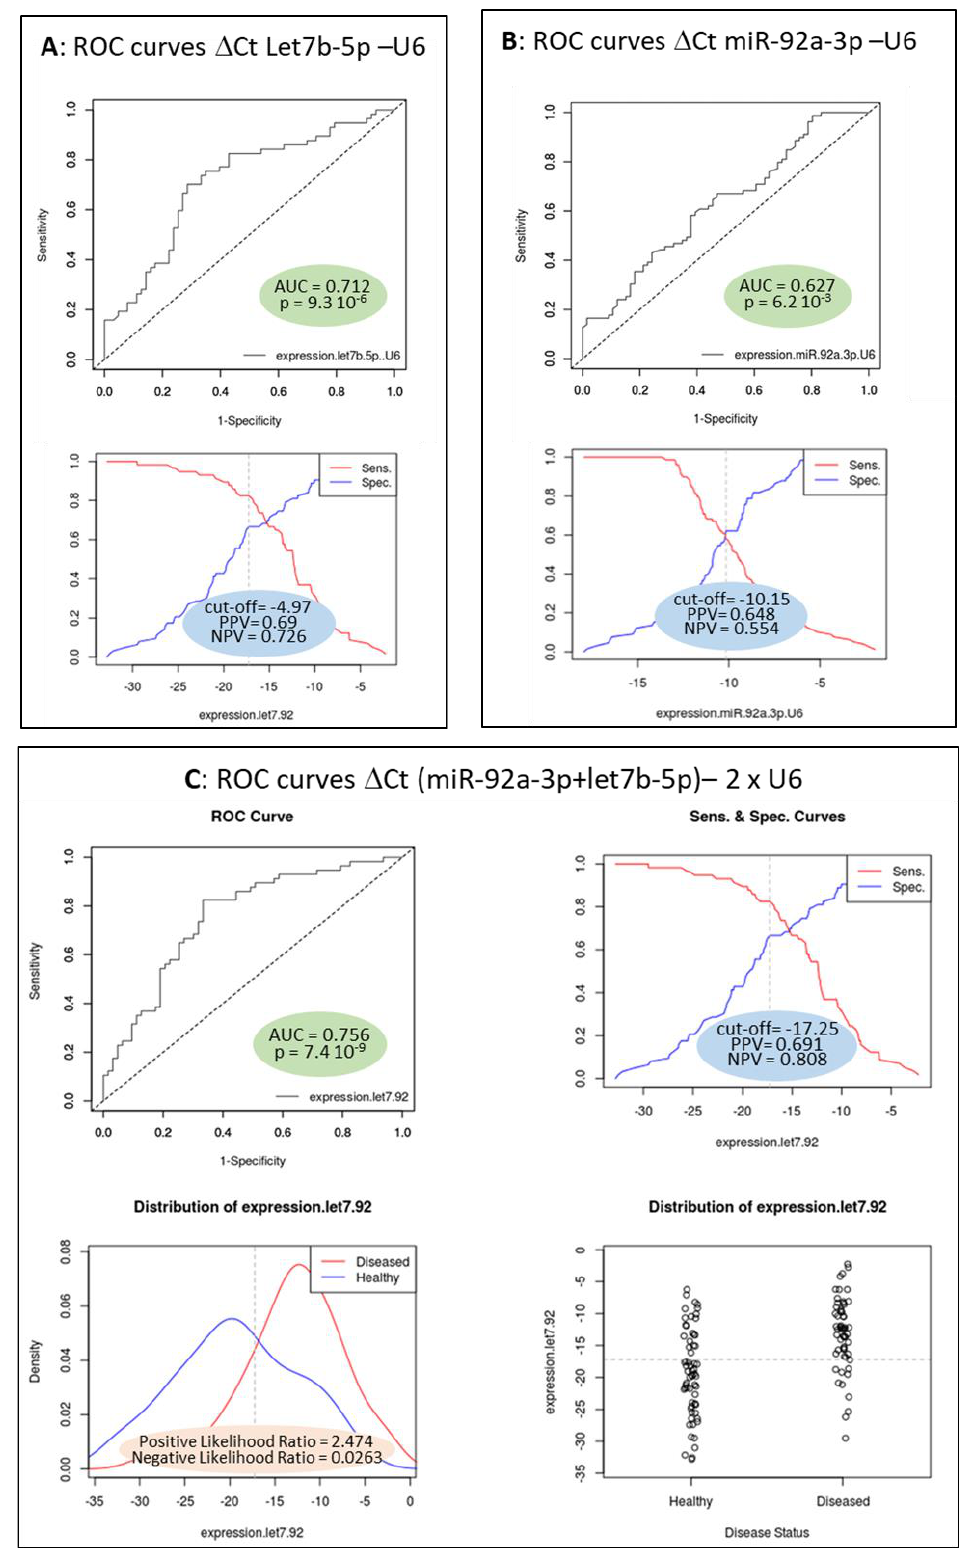
Figure 3. ROC curves for plasmatic levels of let-7b-5p ( A ), miR-92a-3p ( B ) and the combination of both, called in the figure “ expression.let7.92 ” (in every case, the Ct of the miRNA of interest – Ct of U6 taken as reference, or the sum of both from the RT-qPCR experiments) ( C ) for discriminating endometriosis. n = 93 in endometriosis group and n = 95 in control group.